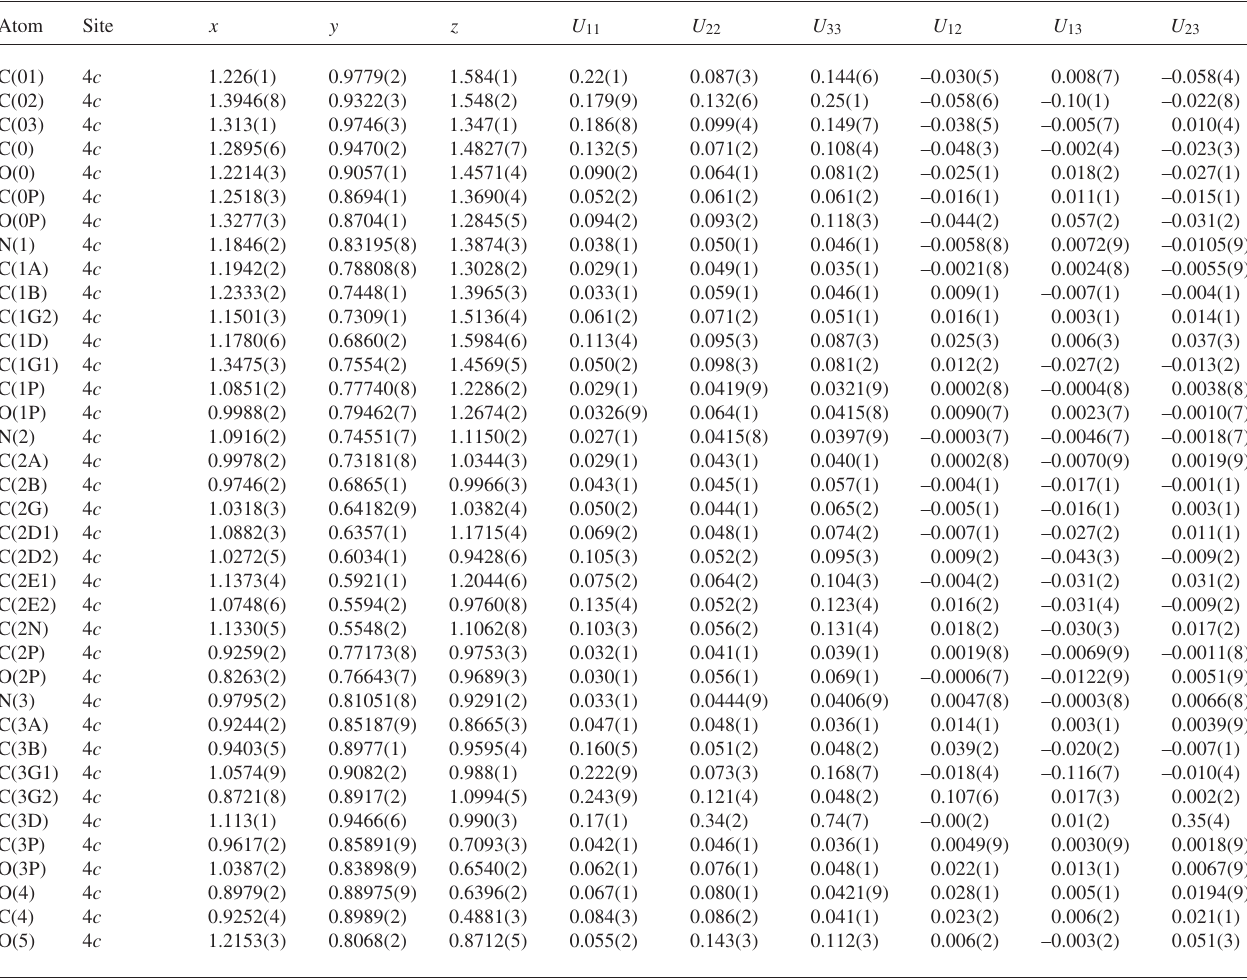
Table 3. Atomic coordinates and displacement parameters (in Å 2 )